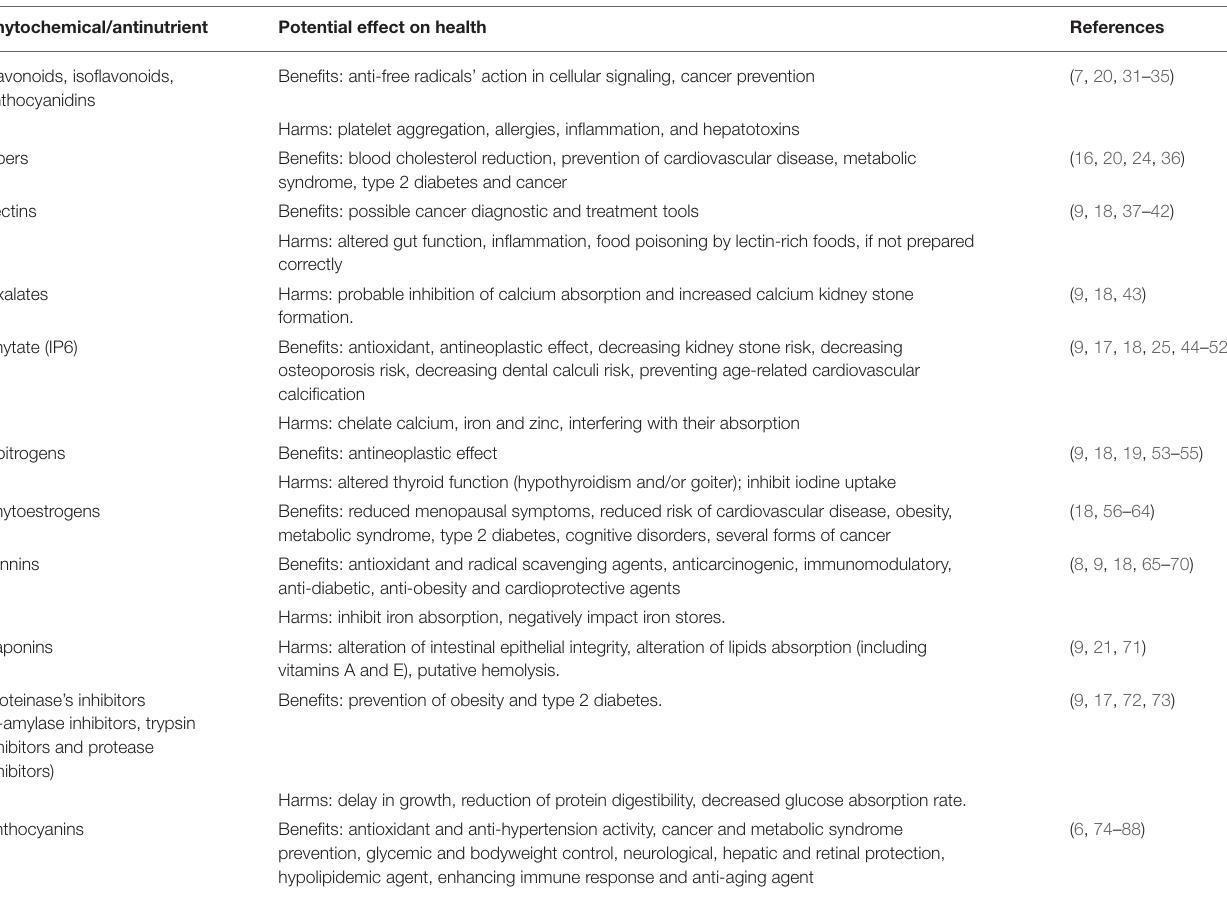
TABLE 2 | Phytochemicals in cereals and their effects on